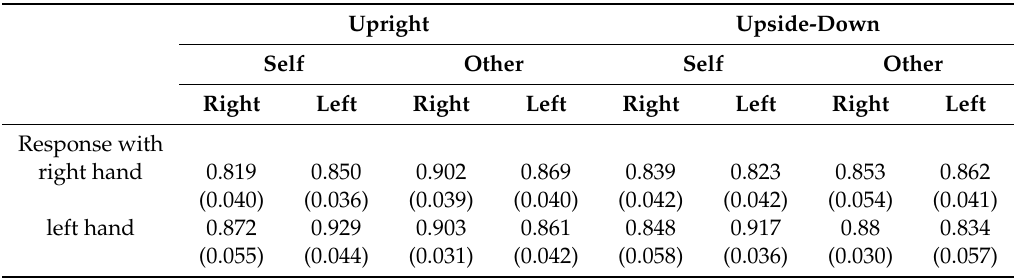
Table 2. Mean accuracy (standard errors) of discrimination between a partner’s and an unknown opposite-sex person’s hands when responding with the right and left hands (Task